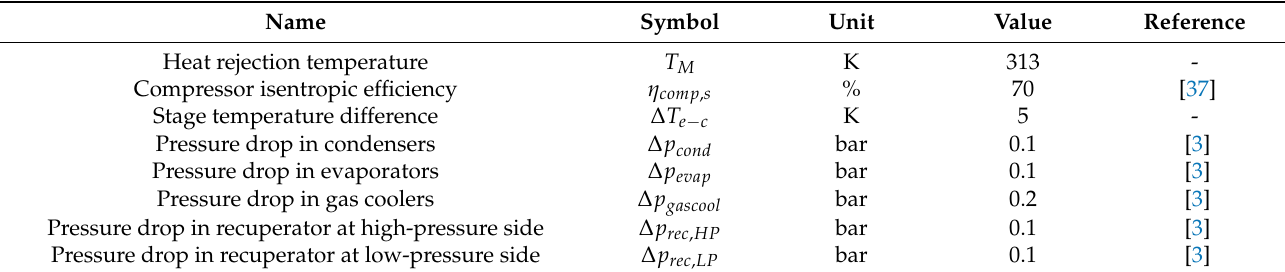
Table 2. The modeling